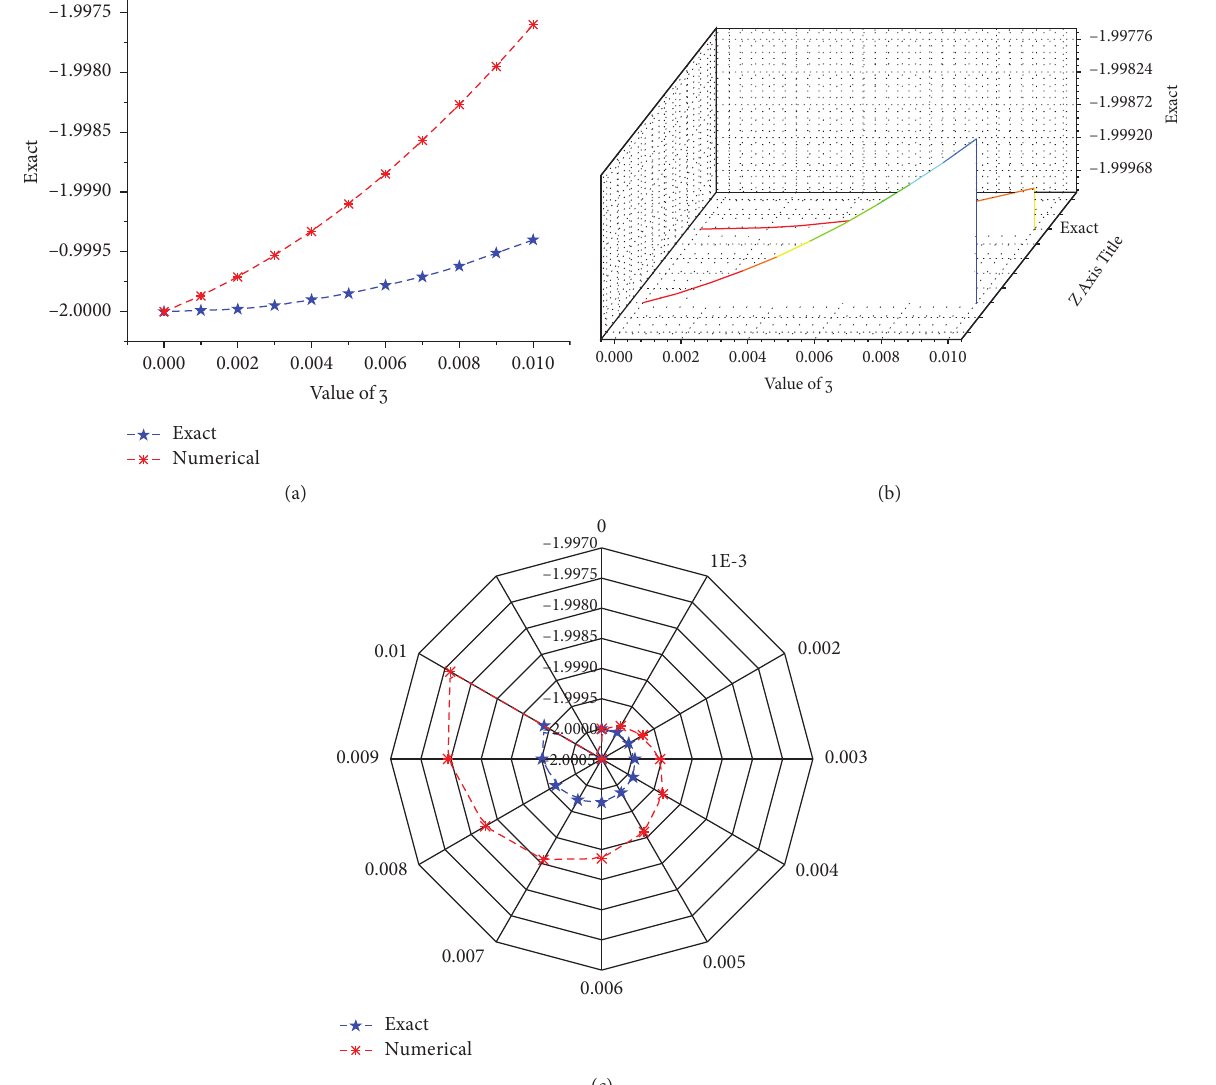
Figure 5: Exact and numerical solutions of equation (10) according to the obtained analytical solution via the extended simplest equation (vii) Tables 1 and 2 show calculated values of the exact, semianalytical, and numerical solutions with dif- ferent values of Z . These values show the accuracy of the obtained analytical solutions via the sech- tanh expansion method over the obtained analytical